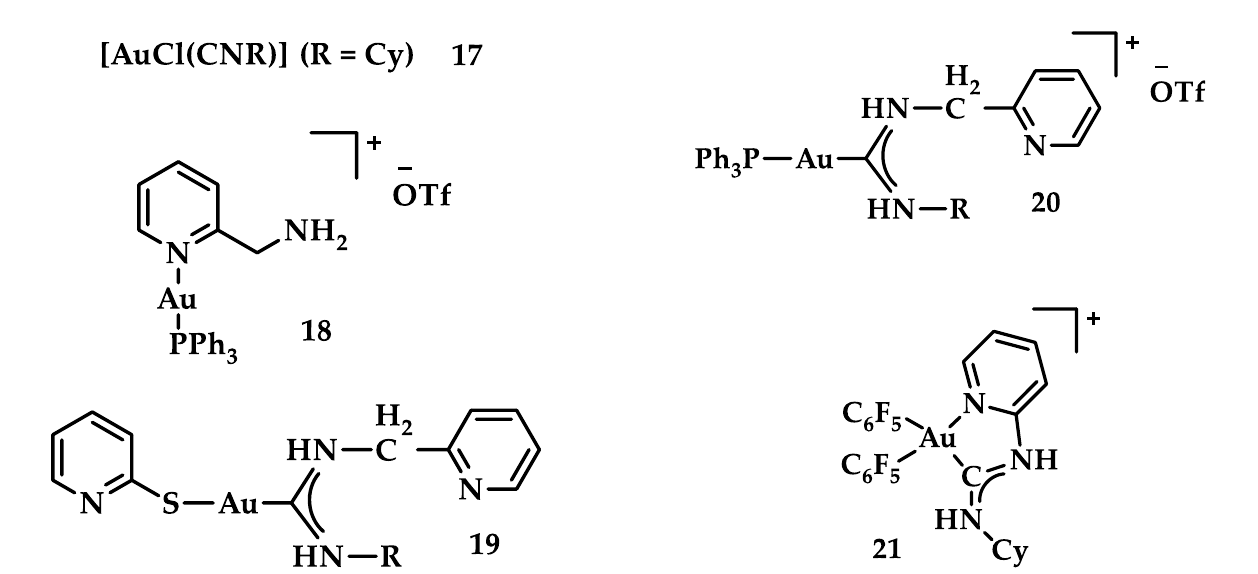
Figure 24. Chemical structures of Au(I) ( 18 – 20 ) and Au(III) ( 21 ) of neutral and/or cationic acyclic diamino carbenes.